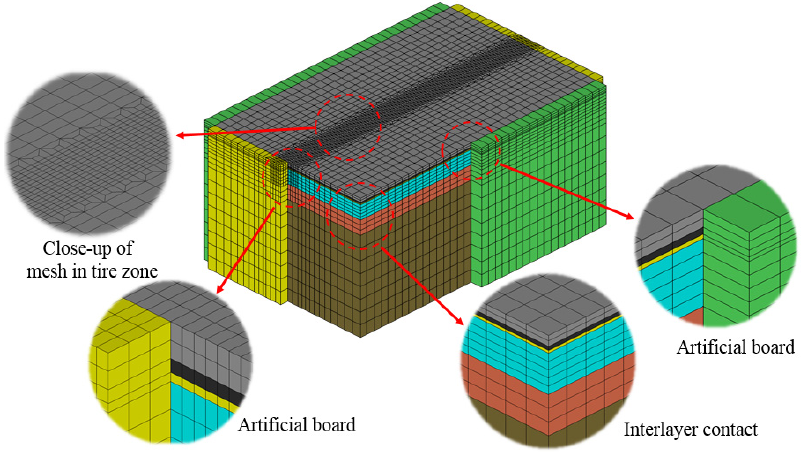
Table 3. The values of correction coefficients α T and α N.